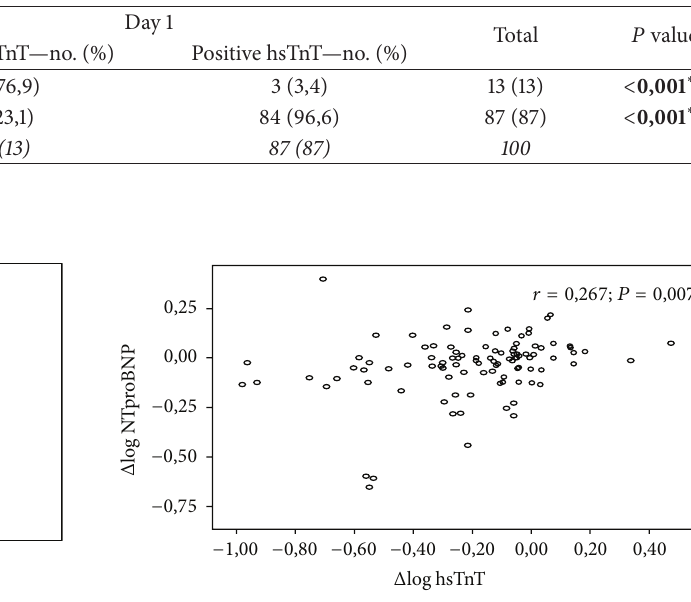
Figure 2: Correlation between Δ Log hsTnT and Δ